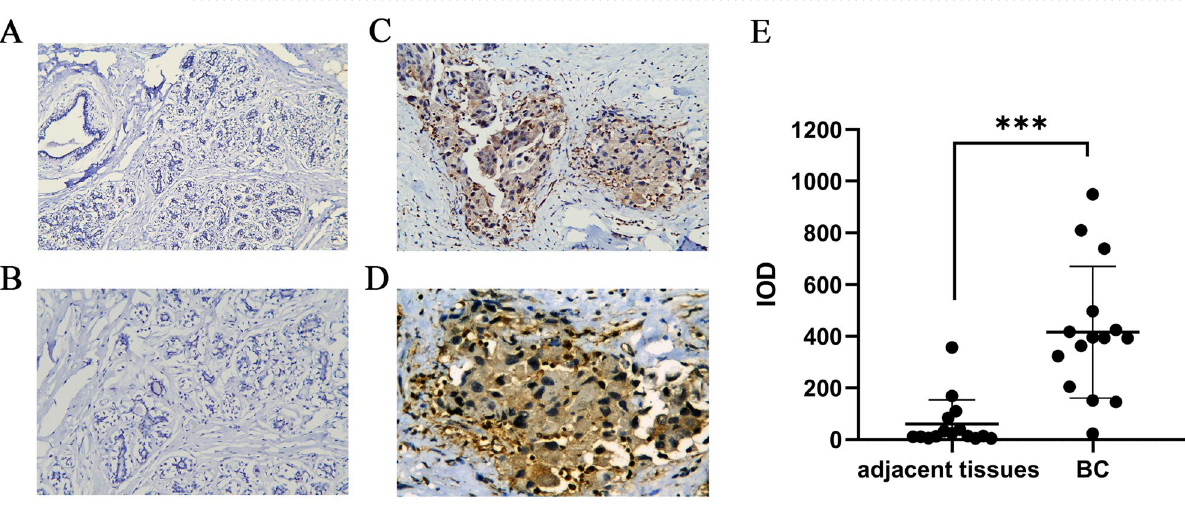
Figure 7. GSDMC protein expression analysis. ( A ) GSDMC protein expression in normal breast tissue (× 200 magnification); ( B ) GSDMC protein expression in normal breast tissue (× 400 magnification); ( C ) GSDMC protein expression in BC tumor tissue (× 200 magnification); ( D ) GSDMC protein expression in BC tumor tissue (× 400 magnification); ( E ) quantification of immunostains for GSDMC by IOD analysis. *** P < 0.001. BC breast